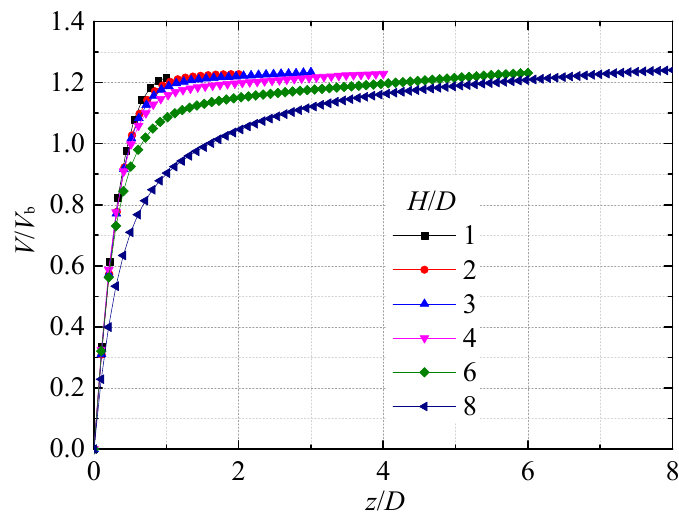
Figure 9. Normalized mean axial velocity V / V b along the jet centerline.